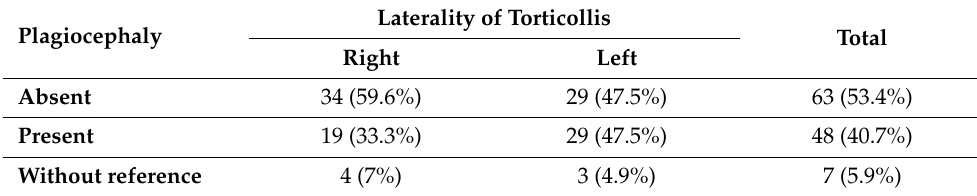
Table 1. Incidence proportion by years and cumulative incidence.